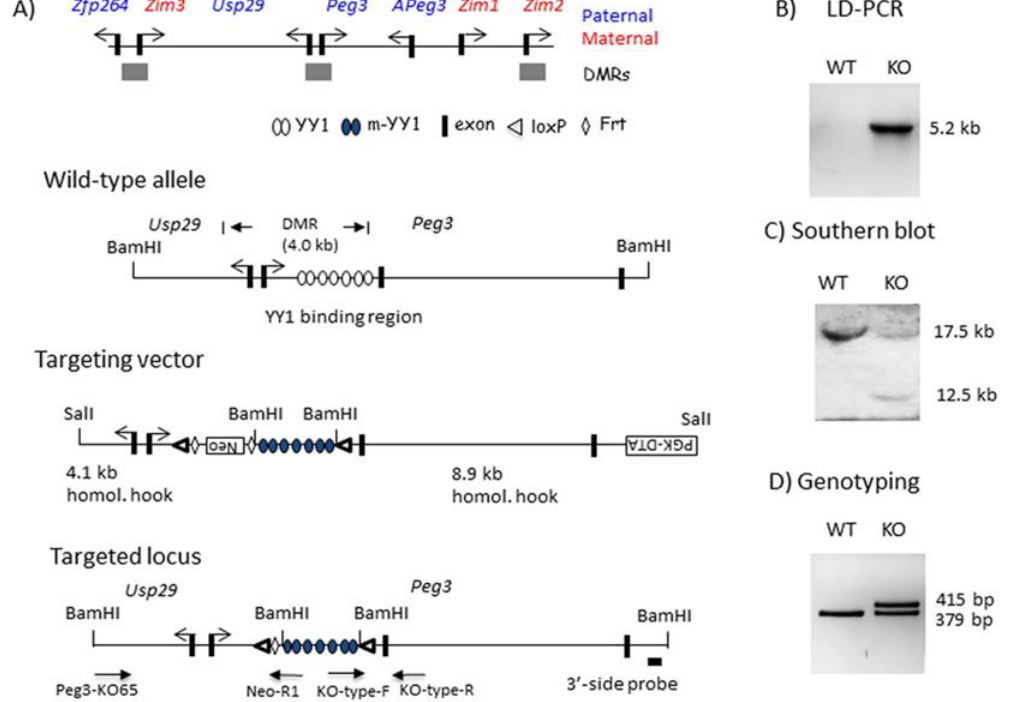
Figure 2. Peg3 domain and the targeting scheme. ( A ) Schematic representations of the Peg3 domain (upper panel). Each imprinted gene is indicated with an arrow. The paternally and maternally expressed genes are indicated with blue and red, respectively. The three DMRs are indicated with gray boxes. Targeting scheme (lower panel). The 4.0-kb Peg3-DMR contains the first exons of Peg3 and Usp29 and the 2.5-kb YY1 binding region. The transcriptional direction of Peg3 and Usp29 is indicated with arrows, and exons are indicated with thick vertical lines. The region corresponding to the neomycin resistance gene ( NeoR ) along with the two flanking FRT sites within the targeting vector are indicated by an open box and diamonds, respectively. Arrows underneath ‘Targeted locus’ indicate primers with relative positions that were used for long-distance PCR and genotyping. ( B ) LD (Long Distance)-PCR. A set of primers, KO65 and NeoR1, successfully amplified the 5.2- kb genomic fragment from the genomic DNA of a heterozygote animal (KO), but not from that of a wild-type littermate (WT), confirming the proper targeting of the KO construct. ( C ) Southern blot analyses on the DNA isolated from ES cells that had been transfected with the targeting vector. The BamH I-digested DNA hybridized with the 3 ′ side probe shows the wild-type allele (17.5 kb) and the targeted allele (12.5 kb). ( D ) PCR-based genotyping. The PCR scheme targeting the 2 nd loxP site with two primers (KO-type-F and -R) derived two DNA fragments representing the wild-type (379 bp) and KO (415 bp) alleles in the